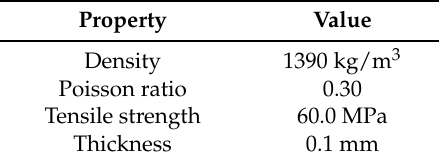
Table 2. Mechanical properties of polyethylene terephthalate (PET) substrate.